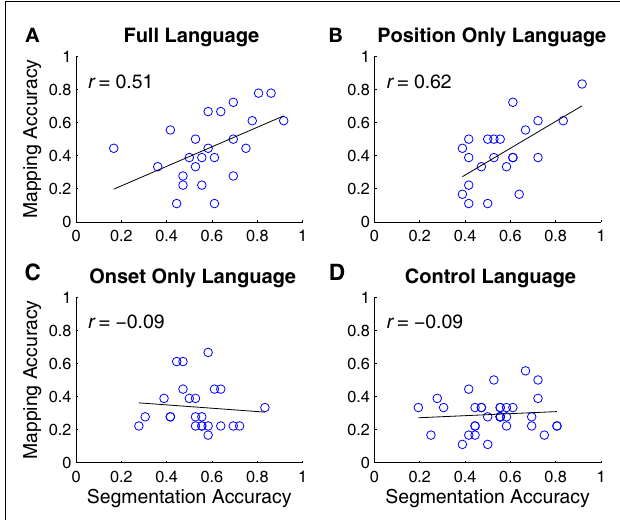
FIGURE 4 | Correlations between segmentation accuracy and word-mapping accuracy in each language condition. Learning the two regularities was positively correlated in the Full (A) and Position Only (B) language conditions, and uncorrelated in the Onset Only (C) and Control (D) language